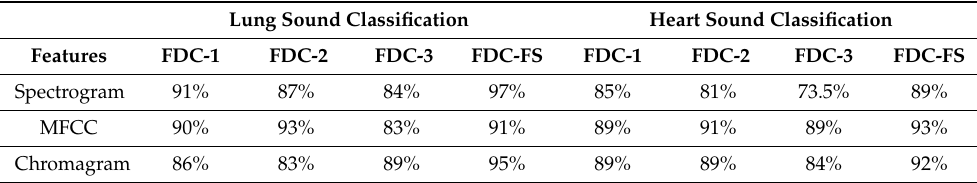
Table 8. Lung & Heart Condition Detection with Original Data (Testing Average Accuracy).